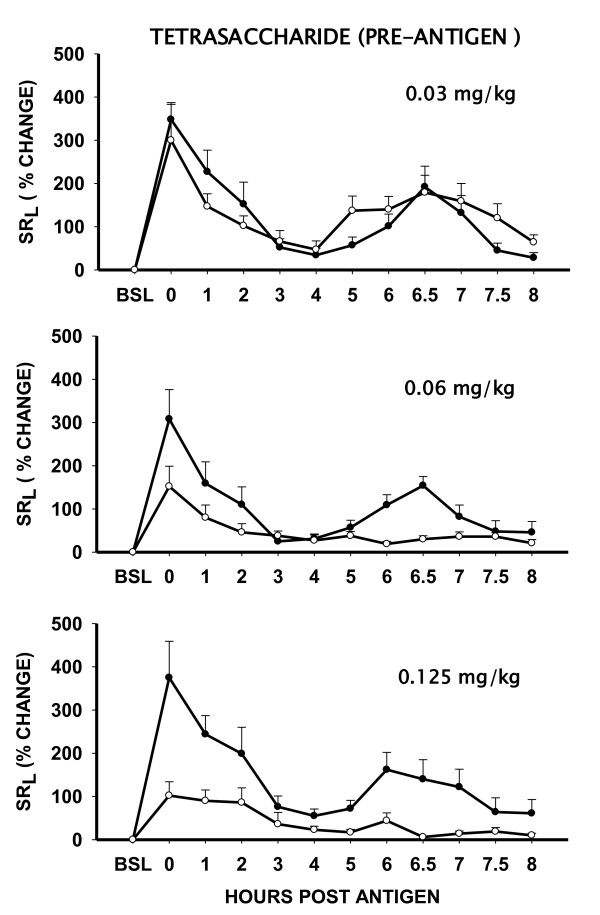
Dose response effect of pretreatment with inhaled heparin tetrasaccharide on antigen-induced early and late airway responses (EAR and LAR) in "Dual Responder" sheep. Data are shown as antigen-induced % change in specific lung resistance (SRL) ± SE without (solid circles) and after pretreatment (open circles) with inhaled tetrasaccharide (0.03 mg/kg, n = 5); 0.06 mg/kg, n = 6); and 0.125 mg/kg, n = 5). BSL = Baseline.